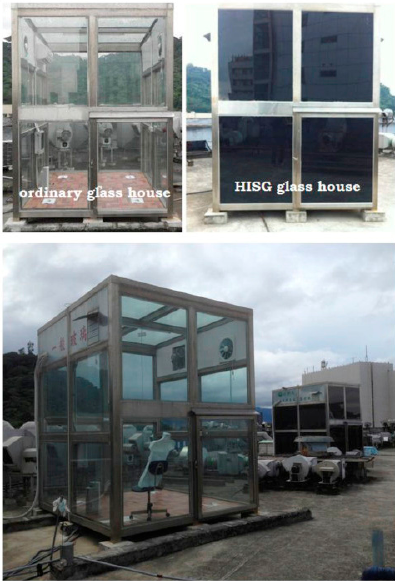
Figure 20. Example of high insulation solar glass system’s outside view [62].